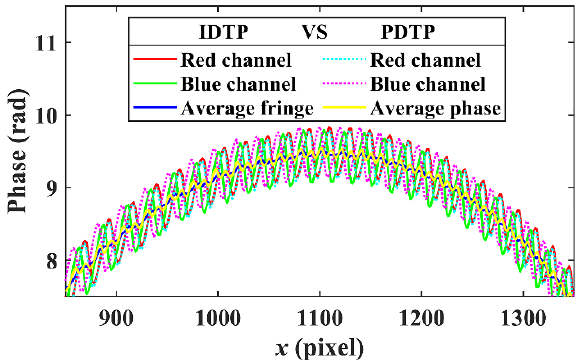
Figure 6. Comparison results of the sphere. ( a ) Distorted color fringe for the proposed IDTP algo- rithm, and the absolute phases recovered from ( b ) the red channel, ( c ) the blue channel, and ( d ) the average fringe, respectively. ( e ) Distorted color fringe for the conventional PDTP algorithm, and the absolute phases recovered from ( f ) the red channel, ( g ) the blue channel, and ( h ) the average phase, respectively.